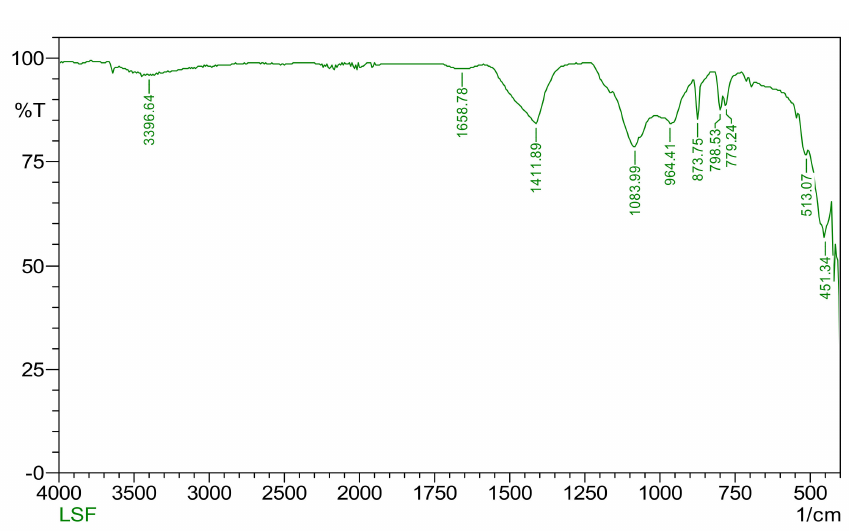
Figure 20. FTIR graph of lime mortar.